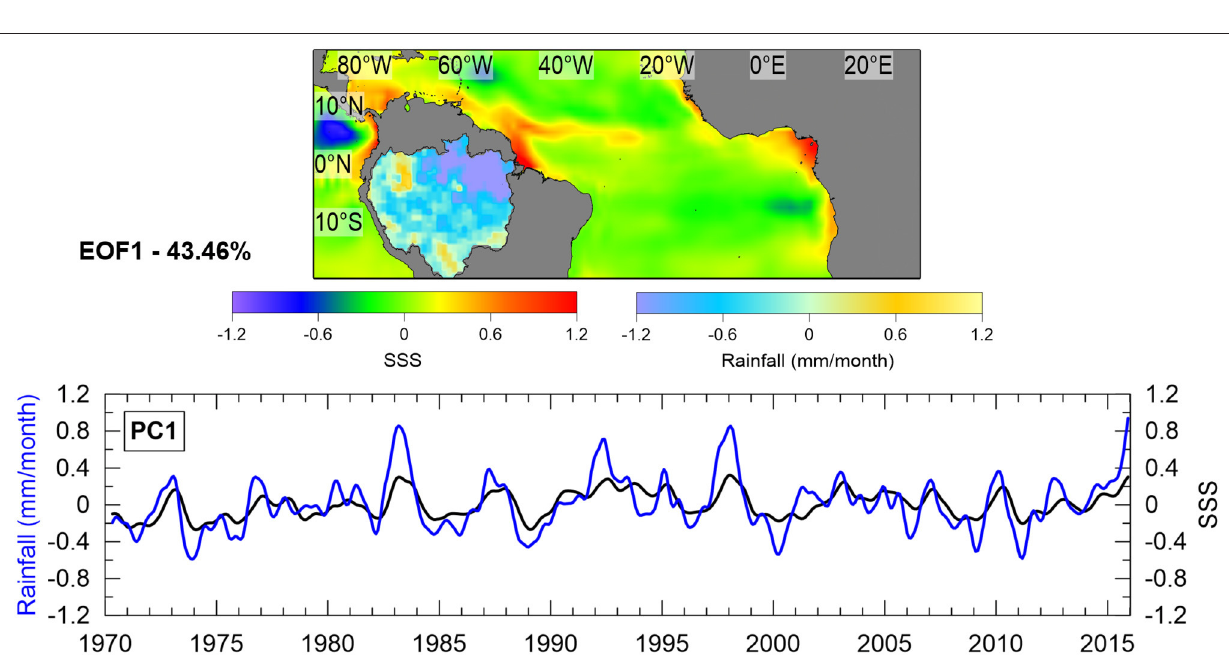
Atlantic was transported by the NBC. North of 10 ◦ N and west of 50 ◦ W there was a core of low SSS, while to the east the low SSS propagated along 10 ◦ N. Some studies have described low salinity cores near Caribbean islands, trapped within NBC rings (Johns et al., 1998; Kelly et al., 2000; Hellweger and Gordon, 2002), with